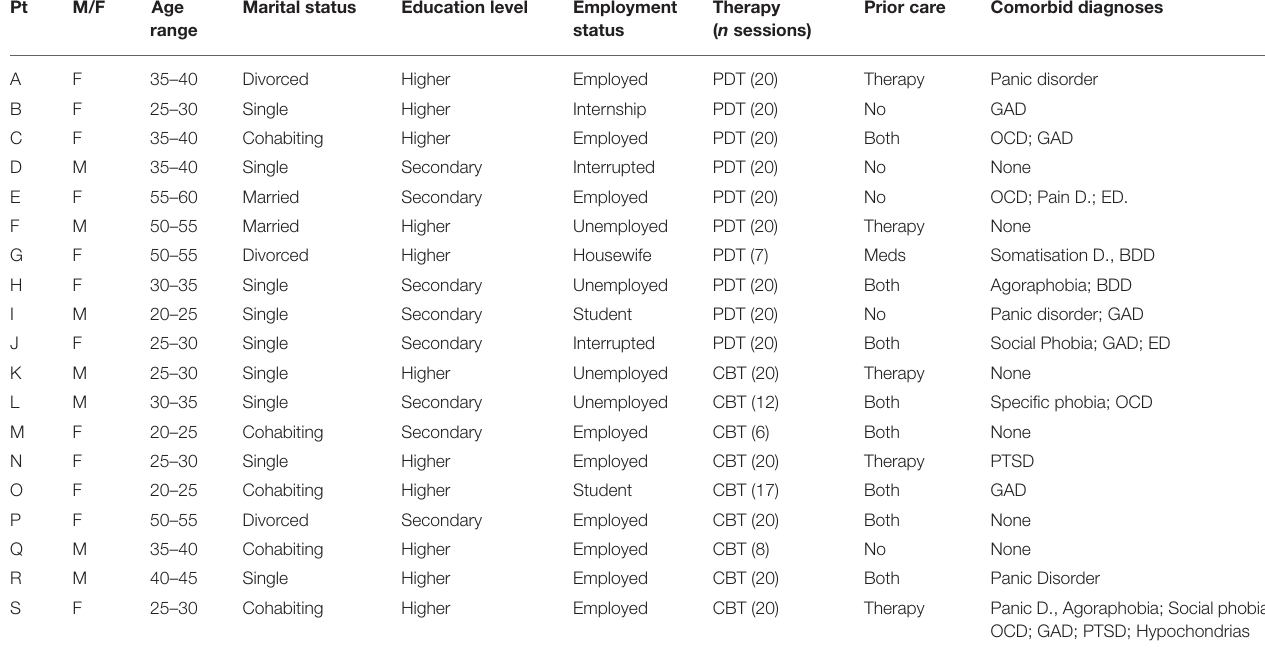
TABLE 1 | Demographical information of patients in the sample.